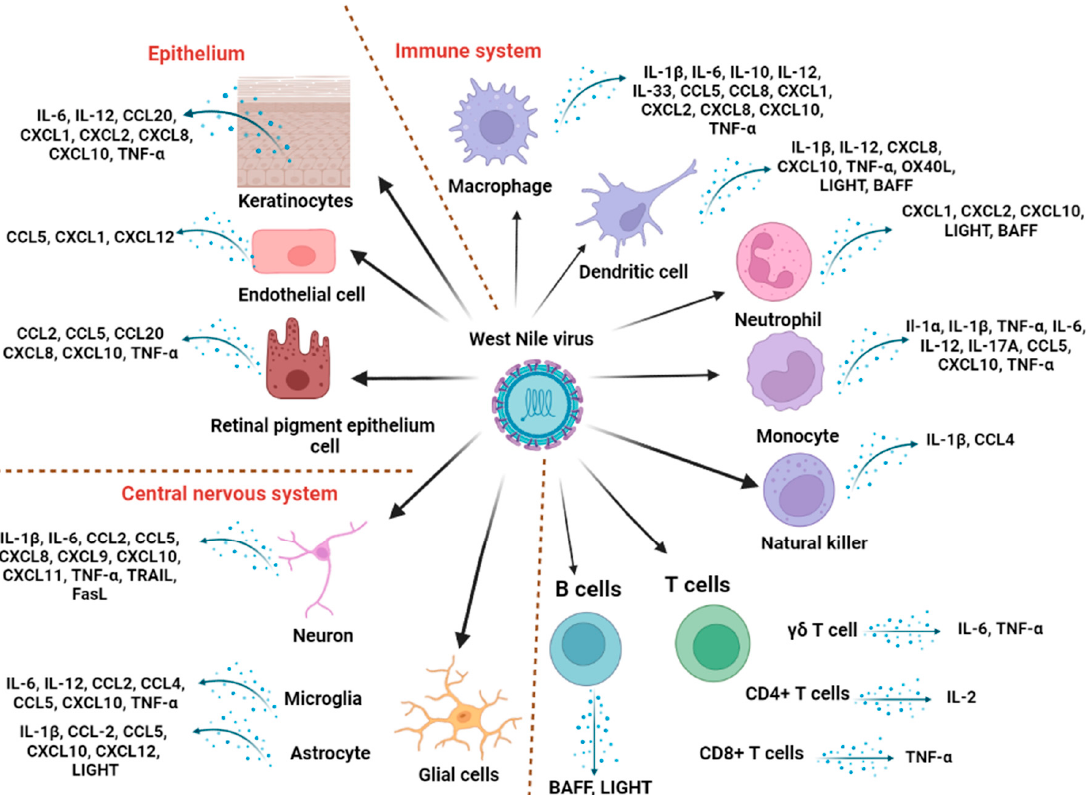
Figure 1. Cellular targets of West Nile virus and corresponding cytokine response in mammals. The illustration was created in Biorender.com. Abbreviations: BAFF: B-cell activating factor; FasL: Fas ligand; TNF- α : tumor necrosis factor - α , TRAIL: TNF-related apoptosis-inducing ligand.